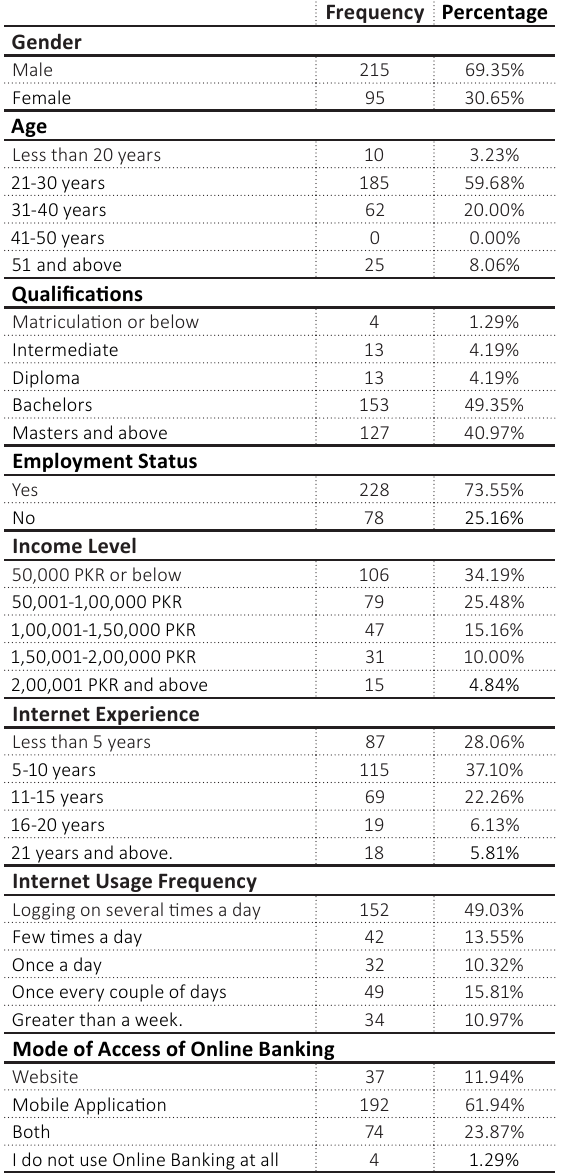
Table 1. Demographics of the data